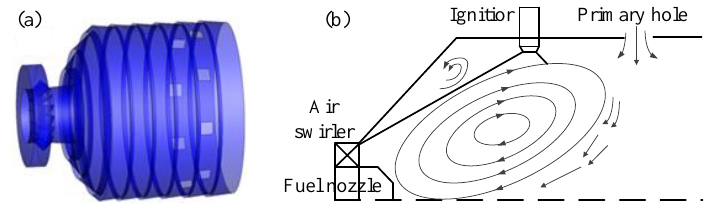
Figure 3. ( a ) Three-dimensional (3-D) computational domain and ( b ) 2-D profile.